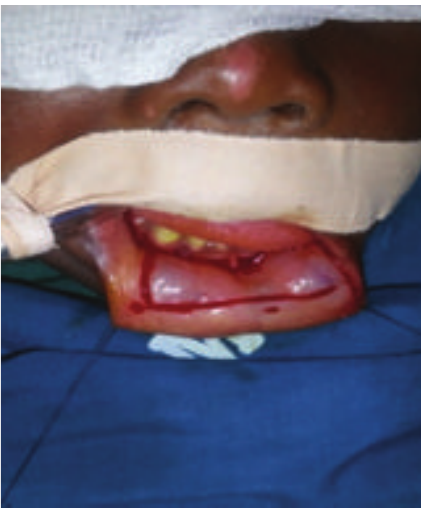
Figure 4: Oral mucosa graft being harvested from the lower lip.